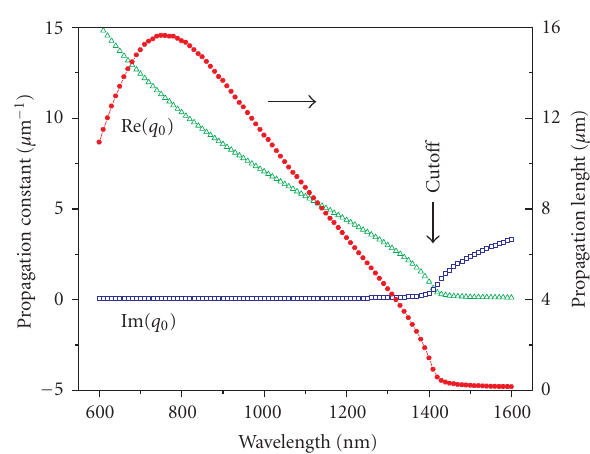
Figure 2: Dependence of the propagation constant and energy propagation length of the fundamental waveguide mode on the wavelength. Here, the opening of the square waveguide (silver) is 400nm ∗ 400nm, the permittivity of the filling medium is 2.25; Re( q 0 ) and Im( q 0 ) represent the real and imaginary parts of the propagation constant, respectively. A maximal propagation length of 15.6 μ m can be achieved at the vacuum wavelength 750